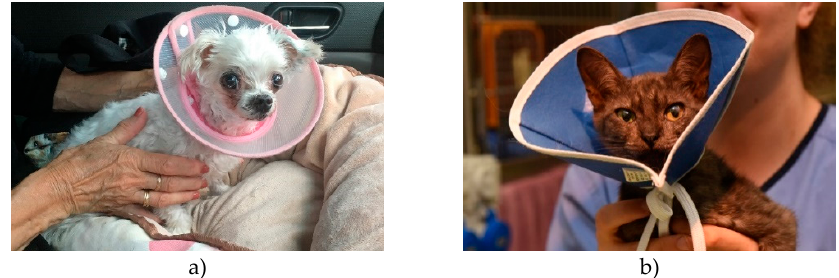
Figure 4. A dog wearing a rigid plastic Elizabethan collar with a soft inner flange and stud-buttons for quicker and more secure fitting; (a) A cat wearing a collar made of flexible plastic material (b) .